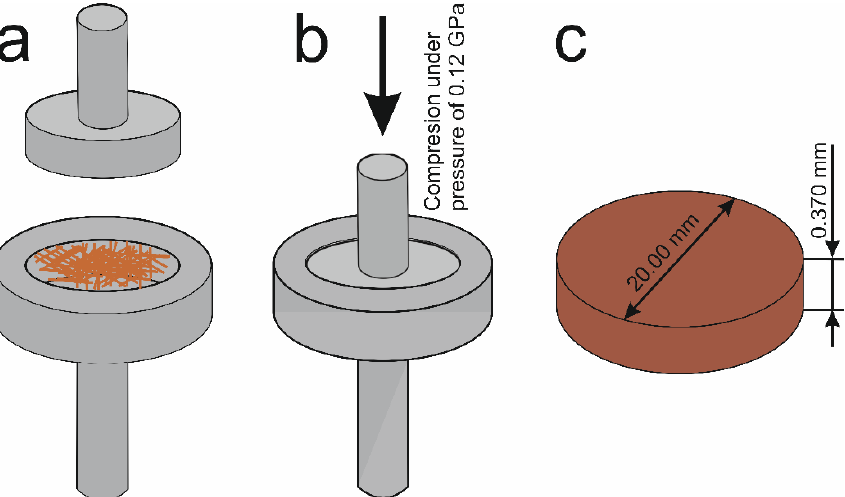
Figure 9. Schematic scheme for the fabrication of a SbSeI pellet: ( a ) filling the steel mould with the sonochemically produced SbSeI nanowires, ( b ) compression of the SbSeI nanowires under a high pressure, and ( c ) the dimensions of the created pellet.